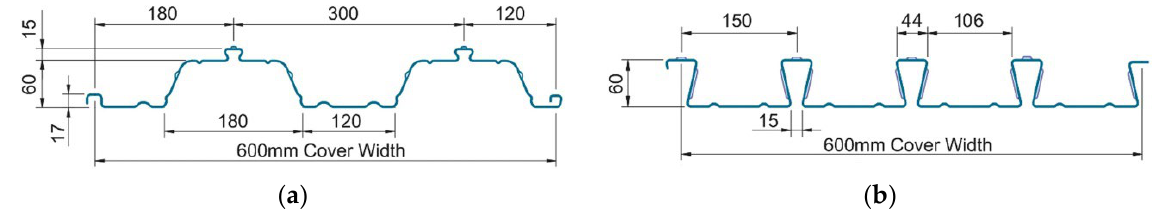
Figure 5. Geometry of steel decking profiles: ( a ) Ribdeck S60; and ( b ) Superib [1].